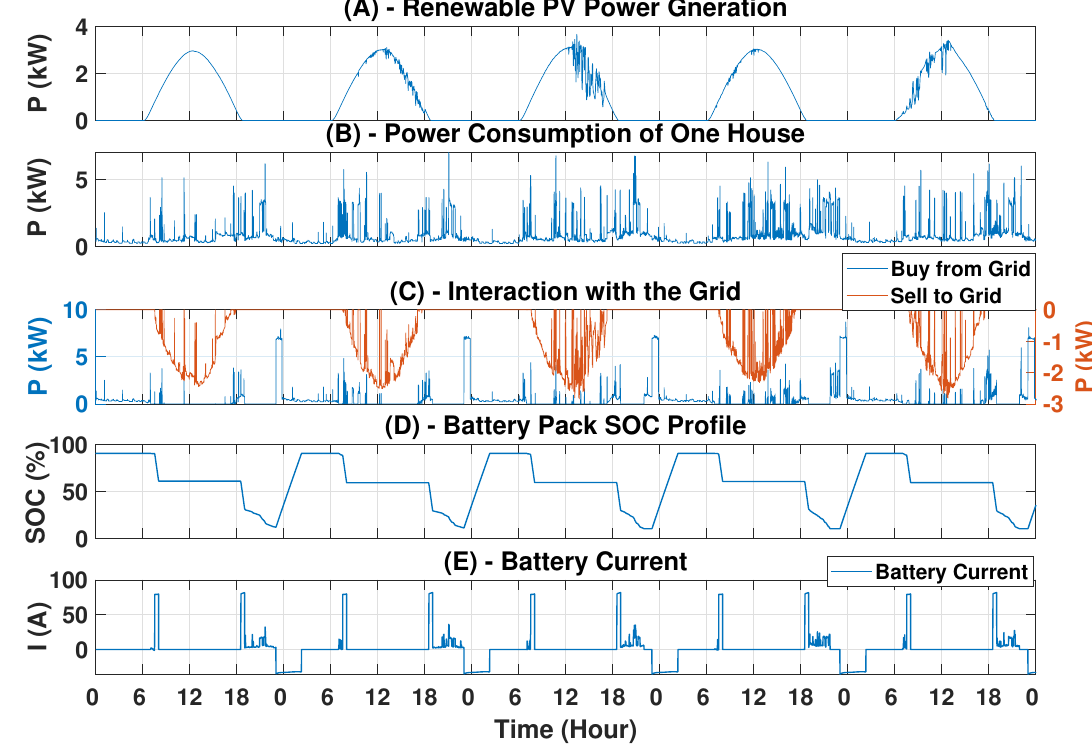
Figure 15. Five-Day simulation of the EES in terms of power tracing quantities. The PV power generation profile is shown in ( A ) illustrate different daily weather conditions; ( B ) reports the load power consumption of one house; the interactions with utility grid to buy or sell energy due to the energy surplus and deficit are illustrated in ( C ); battery SOC profile is shown in ( D ), within its operating range from 10% to 90%; the corresponding battery current is indicated in ( E